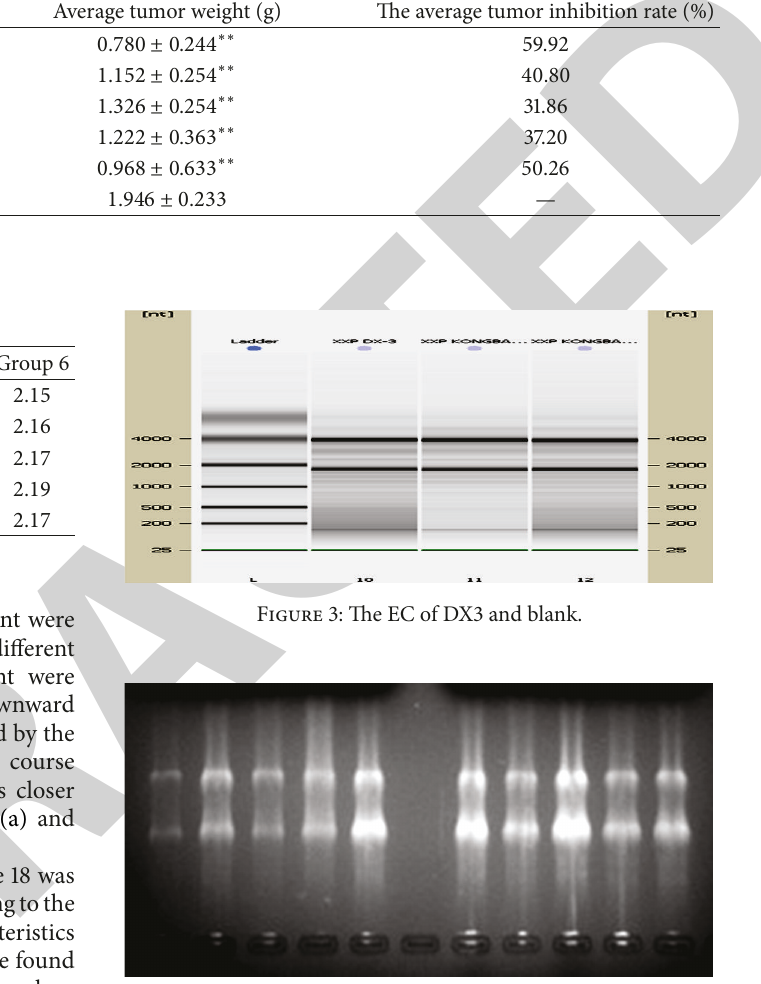
Figure 4: RNA electrophoresis.